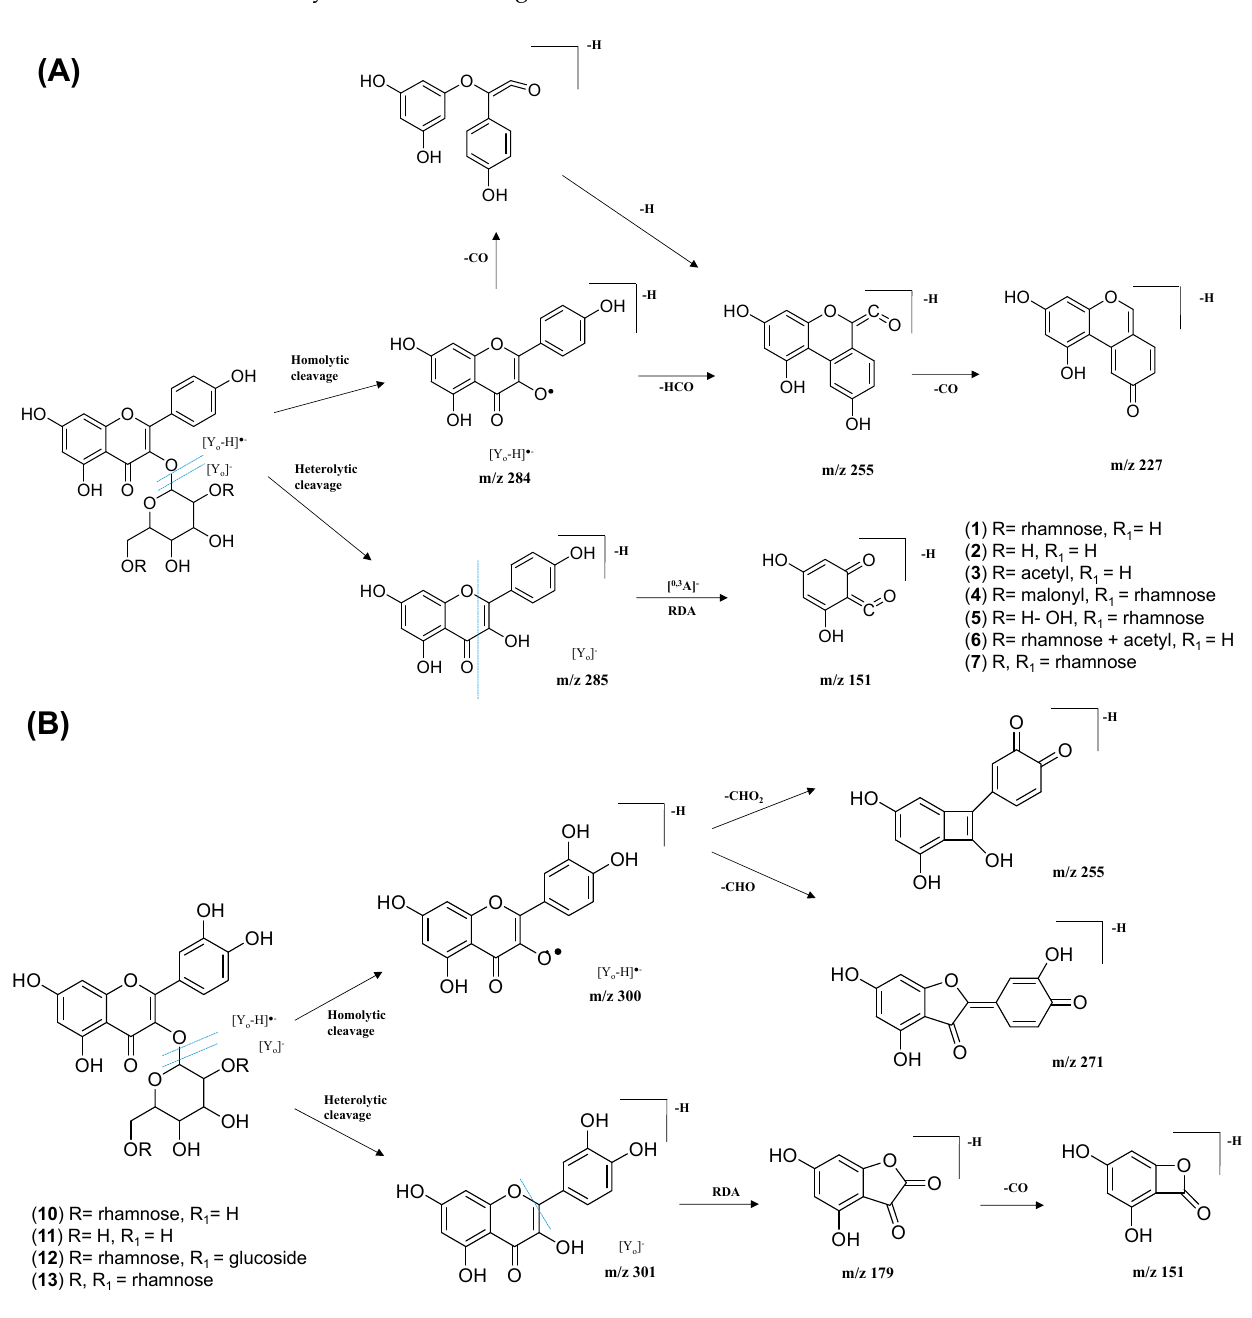
Figure 9. Proposed fragmentation mechanism of ( A ) kaempferol 3- O -glycoside and ( B ) quercetin 3- O -glycoside in negative ion